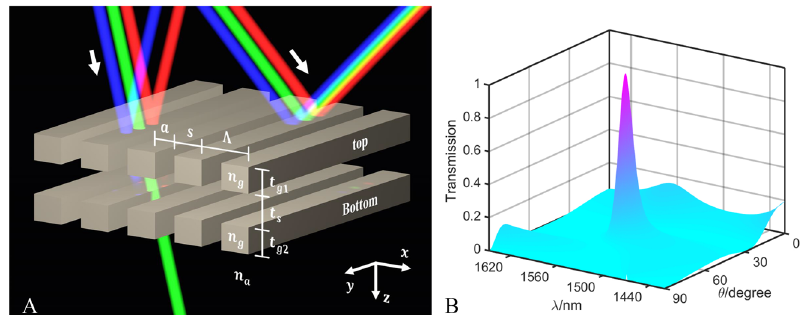
Figure 1: Schematic illustration of narrow- frequency sharp-angular filter using cascaded meta-gratings (MGs). (A) Scheme of a narrow-frequency sharp- angular filter, consisting of two parallel rectangulardielectricMGs.Thegratingbars withhighrefractiveindex n g aresurrounded by atmospheric medium with low refractive index n a . (B) The transverse-magnetic (TM) transmission surface diagram of the narrow-frequency sharp-angular fi lter shows simultaneously angular and spectral transmission selectivity of incident